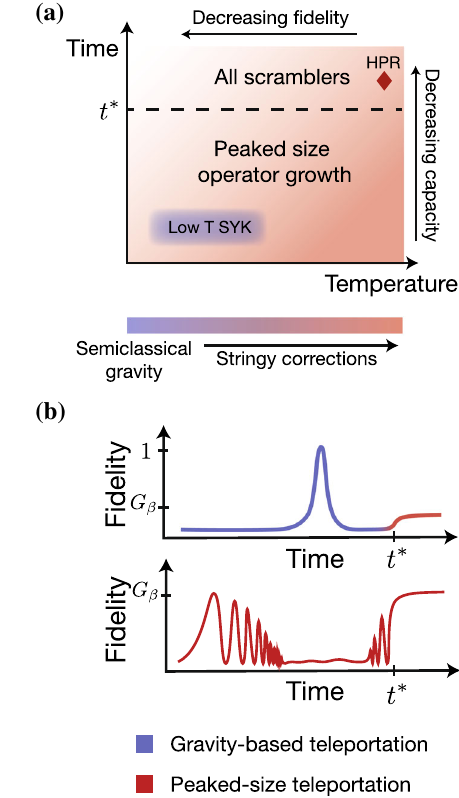
Fig. 10 Summary of the teleportation for different unitary dynamics. TheseplotsaretakenfromRef.[76]withauthors’consent. a Thefidelity of teleportation decreases with temperature. The channel capacity: the number of teleported qubits, decreases at long times. b The fidelity features distinct behavior for holographic and other scramblers for t < t ∗ . For low temperature SYK, which is a model of black holes, the fidelity has a peak at t = t scr while zero otherwise. Whereas for other scramblers it has a ripple like behavior. After t > t ∗ we see a revival of fidelity for SYK saturating at ∝ G β . Thus, after t ∗ all scramblers